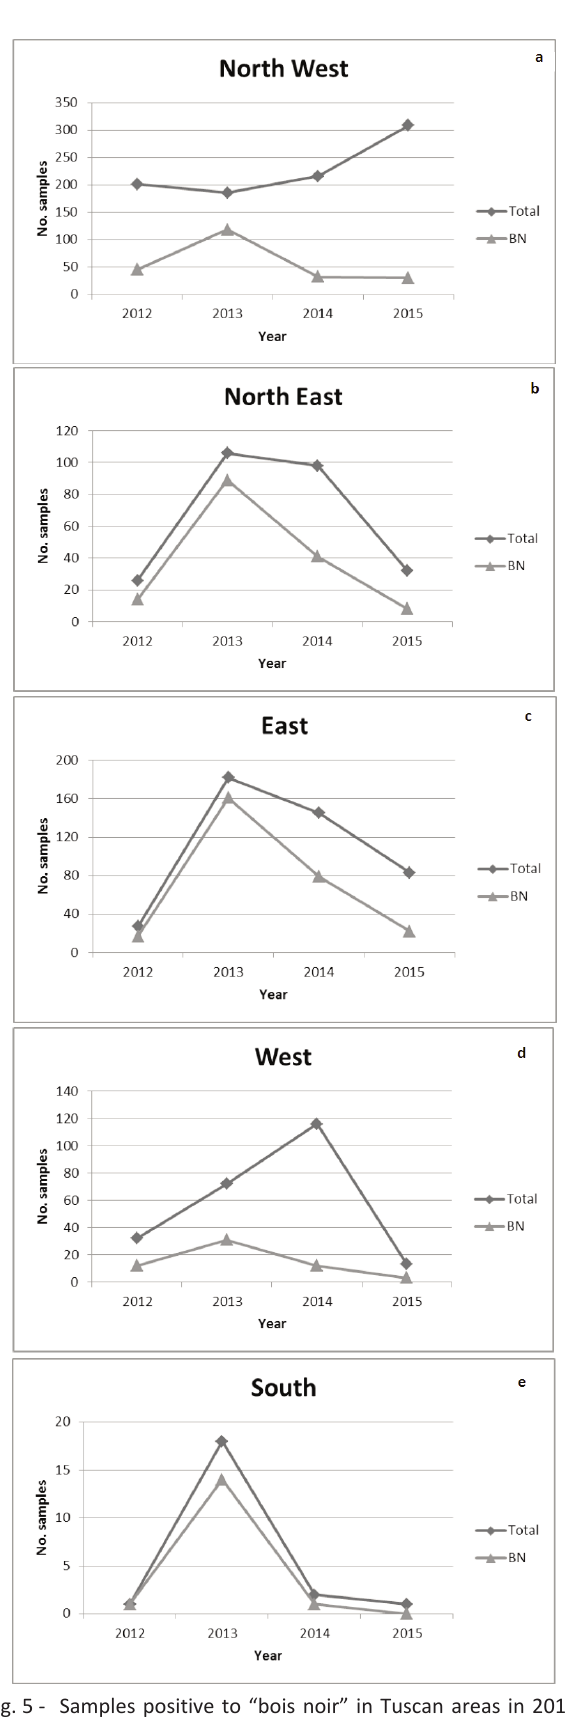
Fig. 6 - Distribution of (a) “flavescence dorée” and (b) “bois noir” subgroups and tufB types respectively in